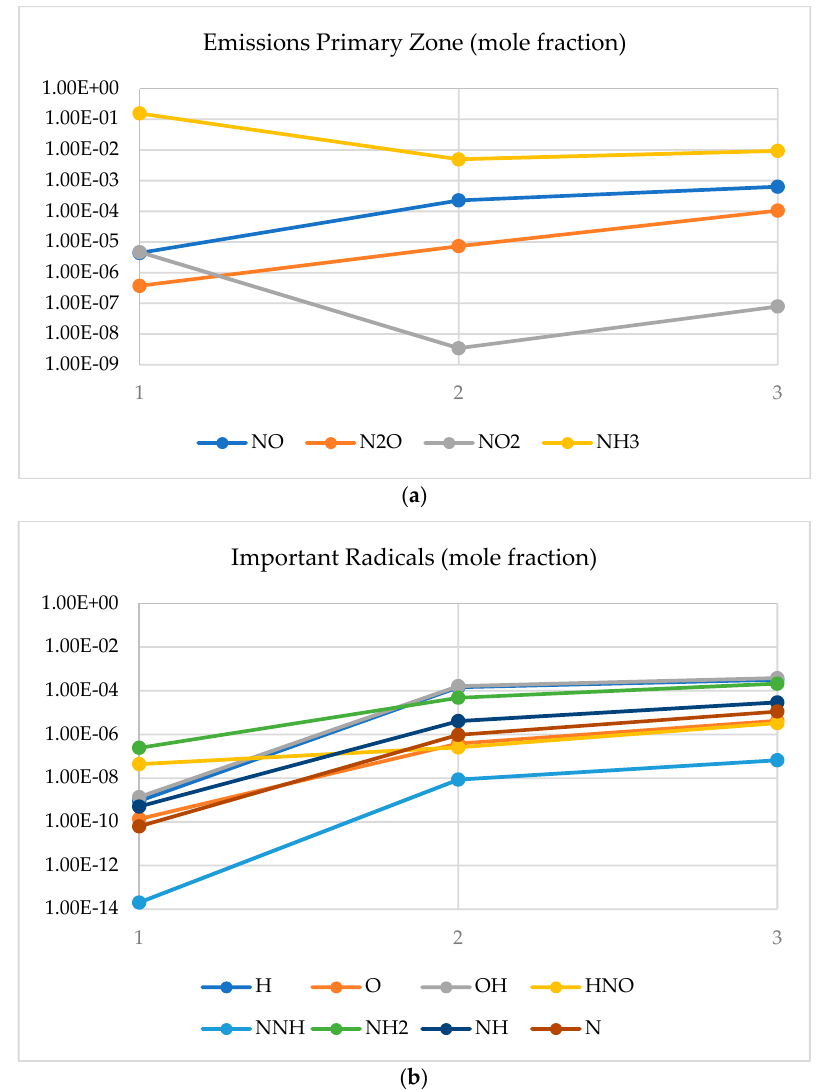
Figure 3. Emissions ( a ) and radicals ( b ) in the primary combustion zone. 1. Mixing; 2. CRZ; 3. shearing flow.